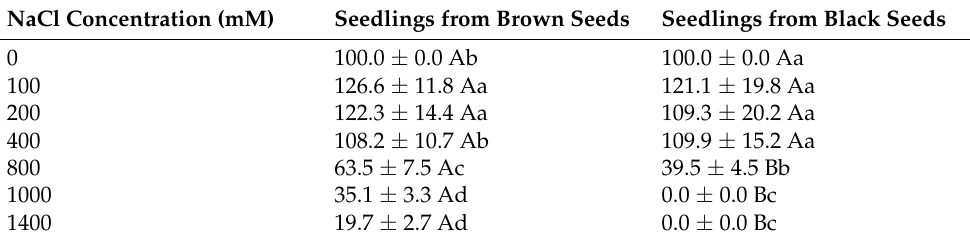
Table 4. Shoot tolerance index of seedlings from dimorphic seeds under different NaCl